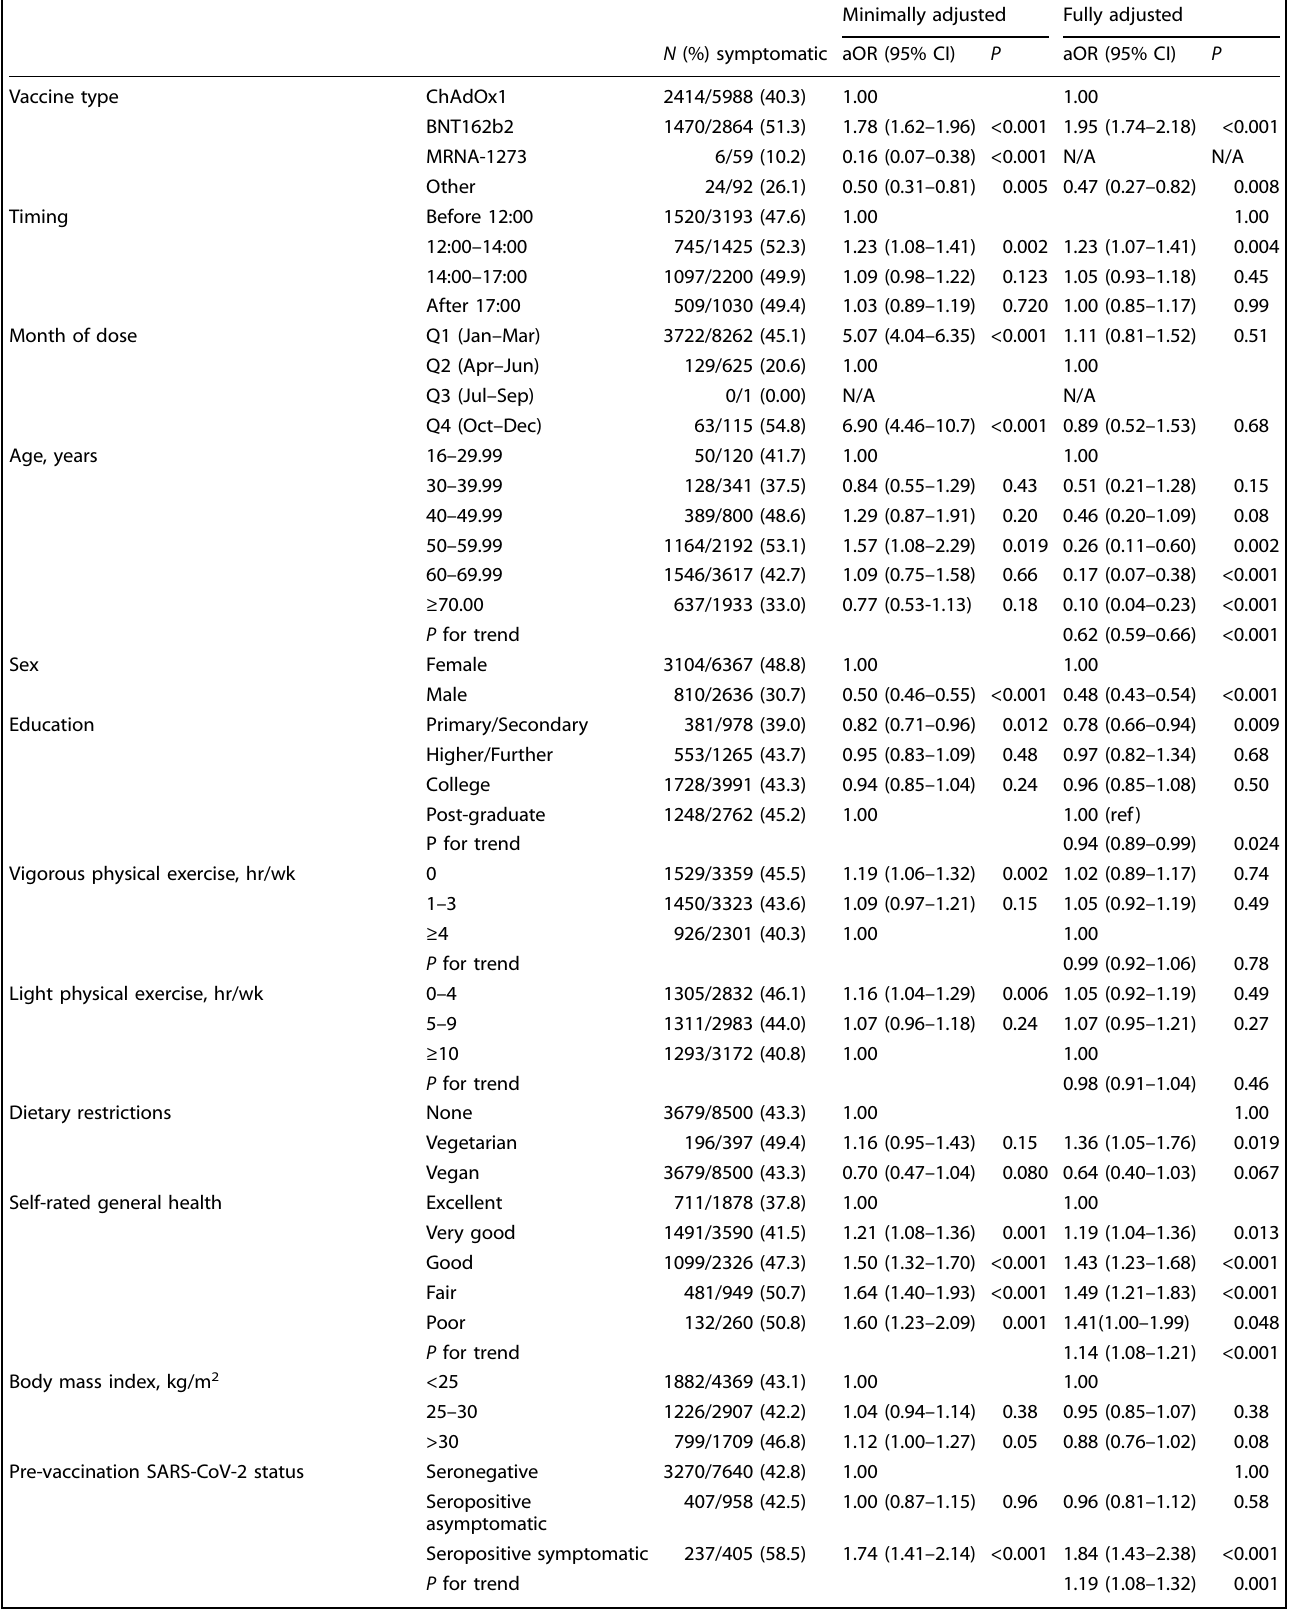
Table 3. Incidence and determinants of local reactive symptoms after a fi rst dose of SARS-CoV-2